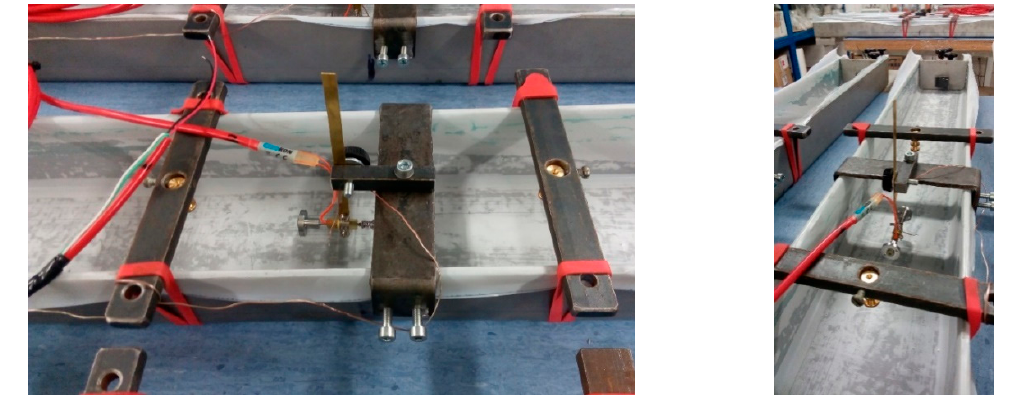
Figure 1. Shrinkage molds 100 mm × 60 mm × 1000 mm before concreting: Position of the wire-type strain gauges and the markers intended for measurement using the mechanical strain gauge.